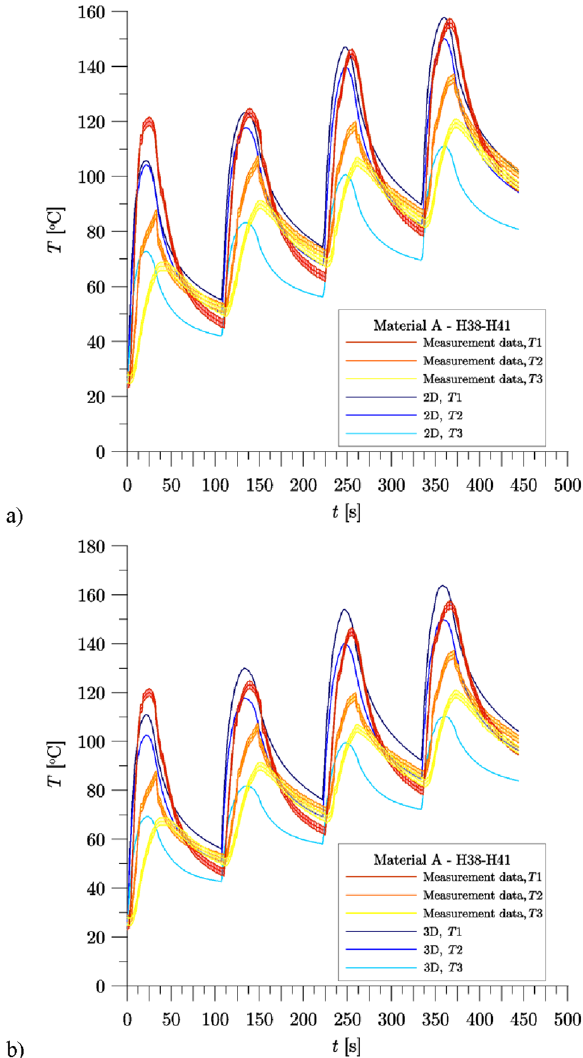
Figure 8. Changes of temperature under the wheel tread during braking H38–H41—comparison of experimental data and numerical calculation results for each temperature measurement points (Material A): ( a ) 2D axisymmetric model; ( b ) 3D model. Experimental data include the maximum uncertainty of the average temperature measurement